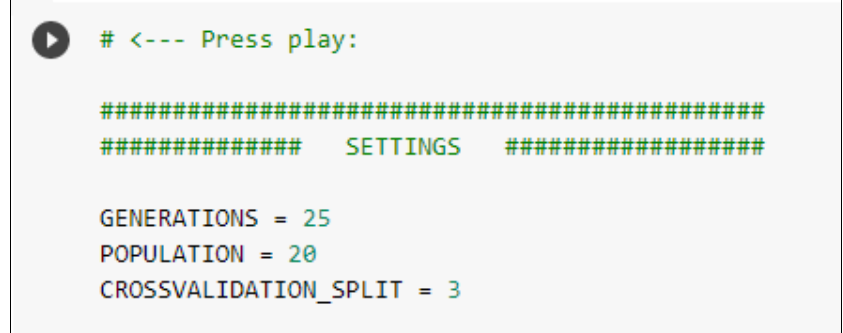
Figure A-6. Select the number of generations